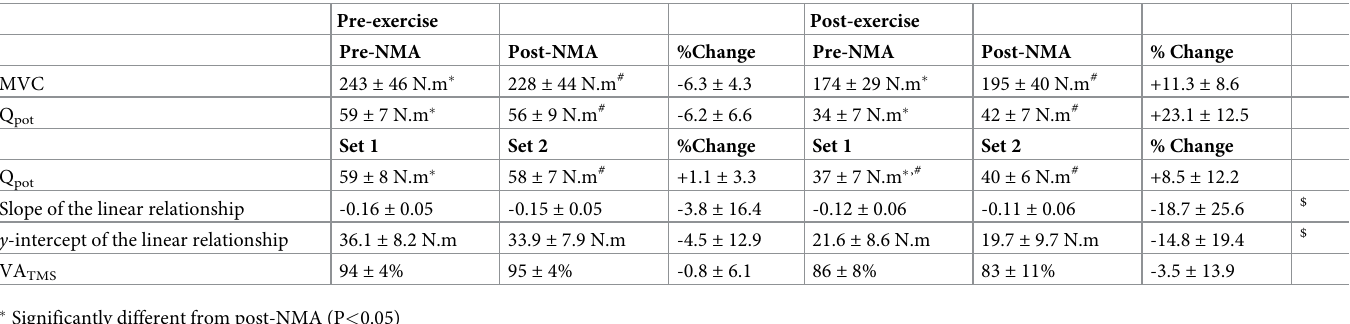
2 = = 11.625, P = 0.008, η 1,9 p